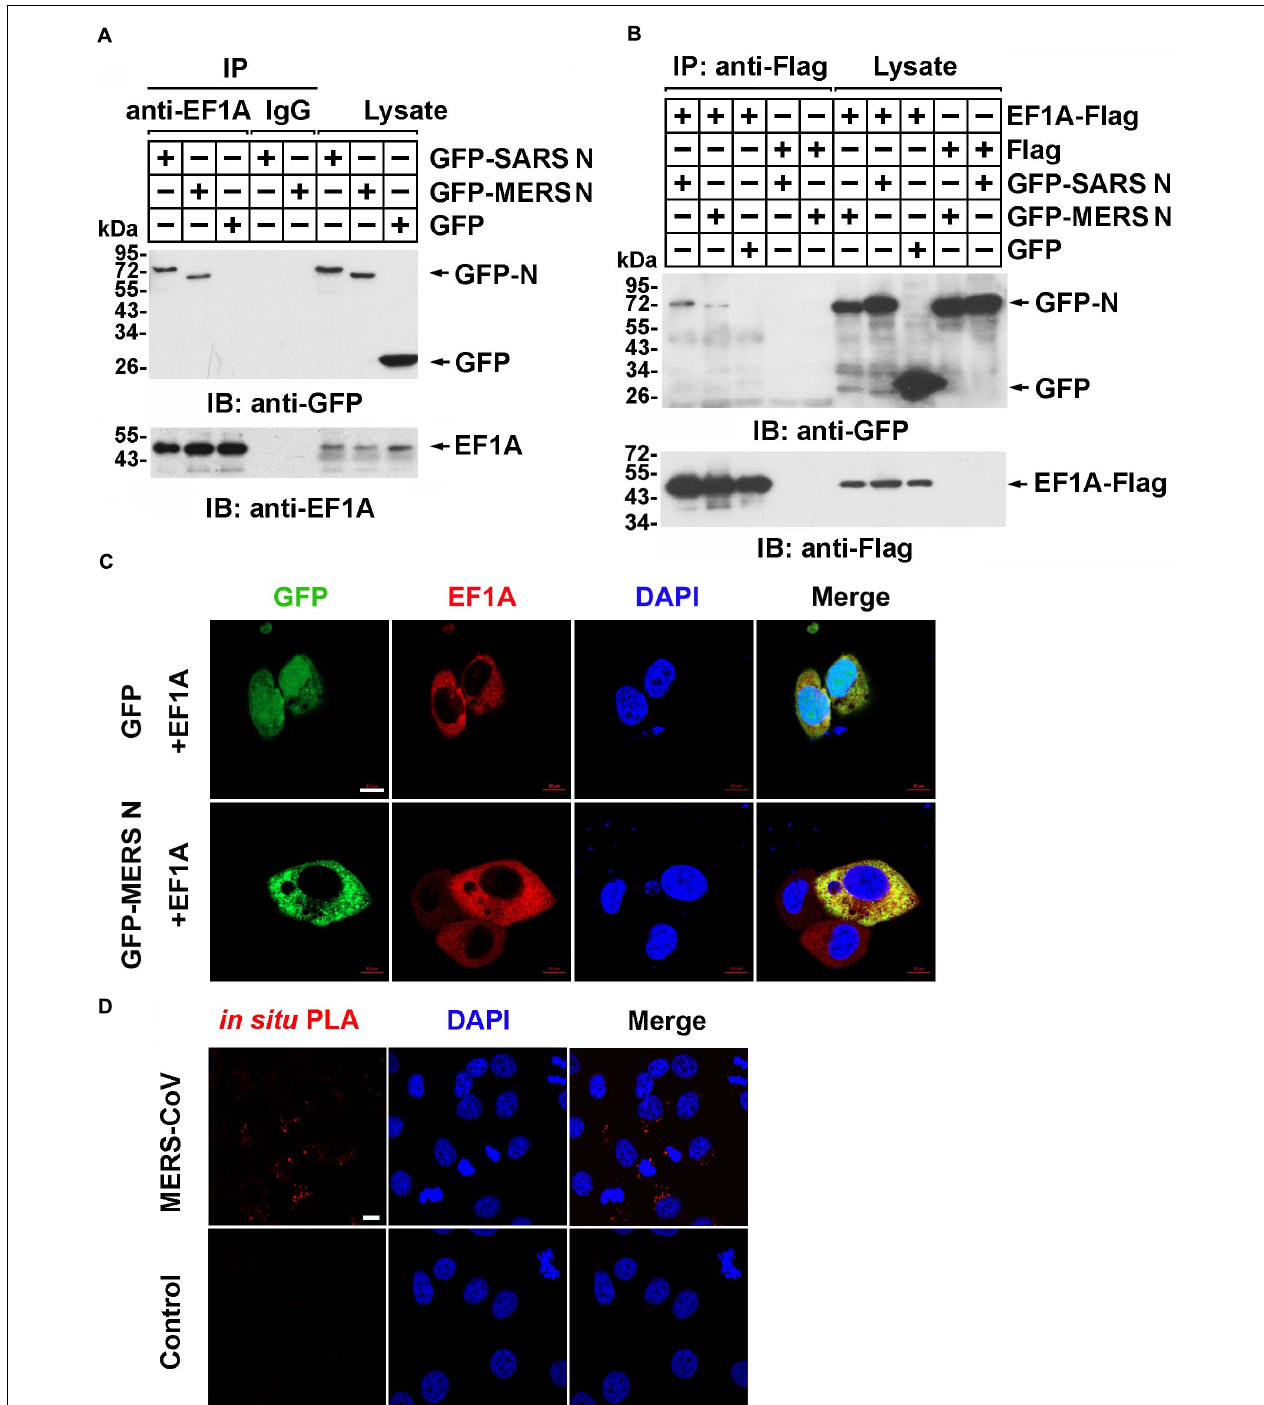
FIGURE 1 | The MERS-CoV N protein associates with EF1A. (A) HEK293T cells transfected with the indicated plasmids. After 48 h, the cell were lysed and incubated with an EF1A antibody or normal rabbit IgG as a control and protein A/G agarose beads. The immunoprecipitates were detected by immunoblotting with anti-GFP and anti-EF1A antibodies. (B) HEK293T cells were transfected with the indicated plasmids. After 48 h, the cell were lysed and incubated with anti-Flag beads. Then, the immunoprecipitates were analyzed by immunoblotting with anti-GFP and anti-Flag antibodies. (C) HeLa cells were cotransfected with GFP-MERS N (or GFP) and EF1A-Flag expression plasmids. After 48 h, cells were fixed and incubated with an anti-EF1A antibody to detect the colocalization of MERS N (green) with EF1A (red) in HeLa cells via confocal microscopy. Nuclei were stained with DAPI (blue). Scale bar, 10 µ m. (D) Vero E6 cells were infected with MERS-CoV (MOI = 0.1) and subjected to an in situ PLA. The red dots indicate the interaction signals, and nuclei are stained with DAPI (blue). Scale bar, 10 µ m.